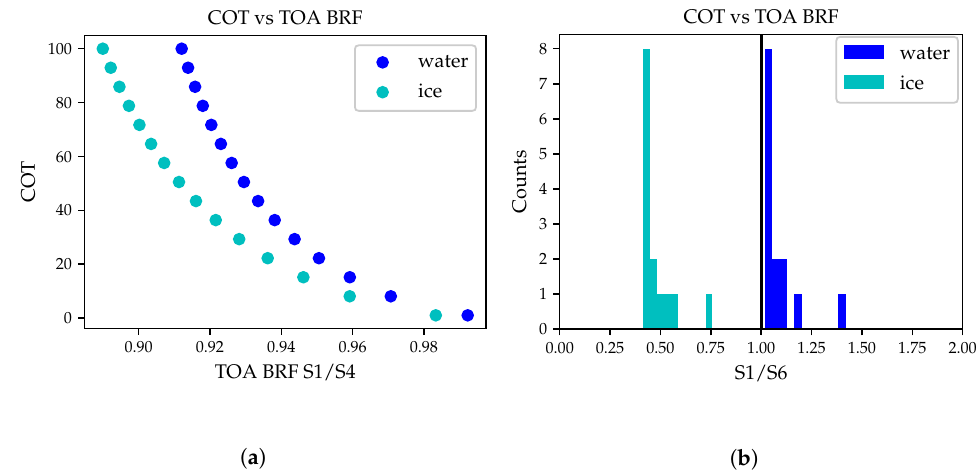
Figure 3. ( a ) The plot of the simulated COT values (y axis) with respect to the ratio between the top-of-atmosphere (TOA) bidirectional reflectance factor (BRF) in band S1 and S4 (x axis) for both ice (cyan) and liquid (blue) clouds. ( b ) The histogram of the distribution of the ratio between the TOA BRF in bands S1 and S6. The color code follows from Figure 2. It can been seen that the ratio is always larger than one (S1 brighter than S6) for ice clouds, while the opposite is true for water